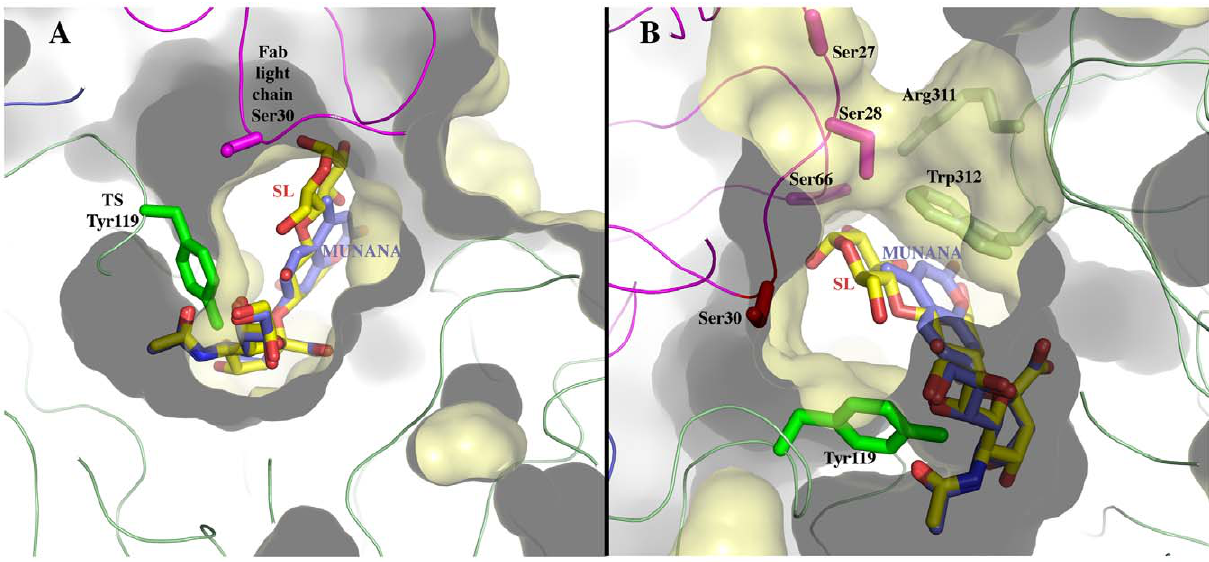
Figure 5. Sialoconjugate substrates modeled in the TS reaction center, in the context of the immunocomplex structure. ( A ) a (2,3)sialyllactose (SL, carbons in yellow) and MU-NANA (carbons in purple) are shown in stick representation, colored according to atom elements (oxygen in red, nitrogen in blue). The carbohydrates are grafted from PDB models 1S0I (for SL) and 1S0J (MU-NANA), after structural superposition of the TS molecules onto the immunocomplex, resulting in their specific positions within the TS catalytic pocket. TS and Fab molecules are shown in ribbons (TS in green, Fab light chain in magenta and heavy chain in blue), with their corresponding solvent-accessible surfaces on top. The surface has been cut to highlight the inner architecture of the TS catalytic pocket: this orientation does not allow appreciating that the site is open from above and beneath the plane of the paper. TS Y 119 (green sticks) is seen directly obstructing the sialic acid position, and its normal mobility is hindered by antibody’s light chain S 30 (magenta sticks). ( B ) A similar representation as in panel (A), in a rotated orientation scene, to highlight the ‘roof’ formed by residues S 66 –G 67 of the Fab light chain (in magenta sticks to the top left of the panel) in direct contact with TS residues R 311 –W 312 (in pale green sticks, to the right of the figure). Note the expected clash of the glucosyl residue in sialyllactose against loop 66–67, and the better fit of the smaller MU-NANA substrate, still quite restricted in free torsional movements. Y 119 is again shown (strong green sticks), precluding entrance of the sialic acid moiety of both modeled sugar compounds.